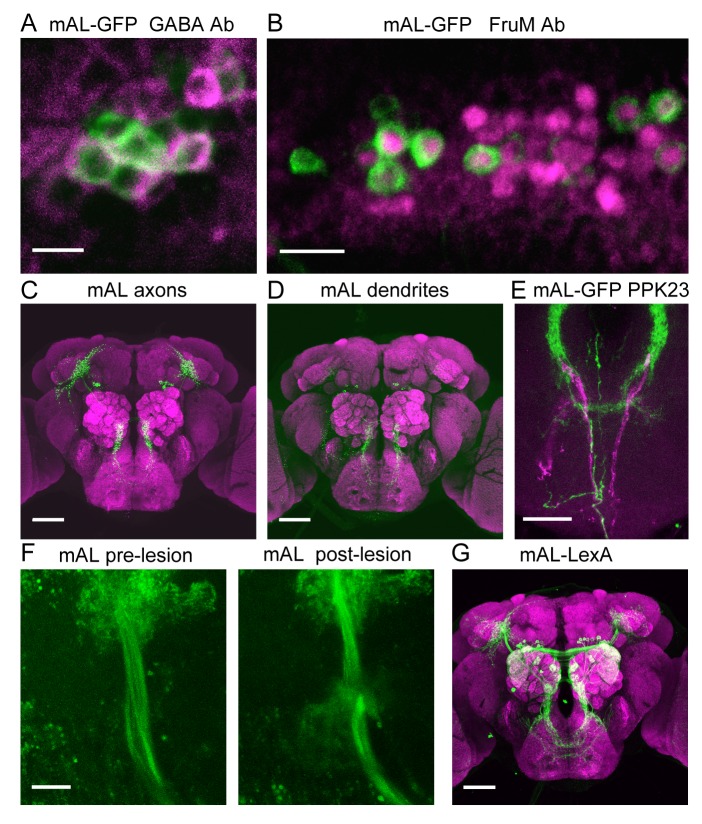
Characterization of mAL neurons.(A) mAL neurons labeled by R43D01-Gal4 (green, CD8::GFP) are immunopositive for GABA (magenta). (B) mAL neurons labeled by R43D01-Gal4 (green, CD8::GFP) express FruM (magenta). (C) mAL neurons have presynaptic termini (green, nsyb-GFP) in the higher brain and SEZ. (D) mAL neurons have dendrites (green, Dscam17.1-GFP) primarily in the SEZ. (E) M cell axons (magenta, myr::mCherry) interdigitate with mAL fibers (green, CD8::GFP) in the SEZ. (F) A representative image of the mAL axonal tract in the higher brain before and after 2-photon-mediated lesioning. (G) R43D01-LexA labels mAL neurons and some olfactory sensory neurons (green, CD2::GFP). This line was used in Figure 6E. Scale bars, 5 μm (A), 10 μm (B, F), 25 μm (E), 50 μm (C, D, G).